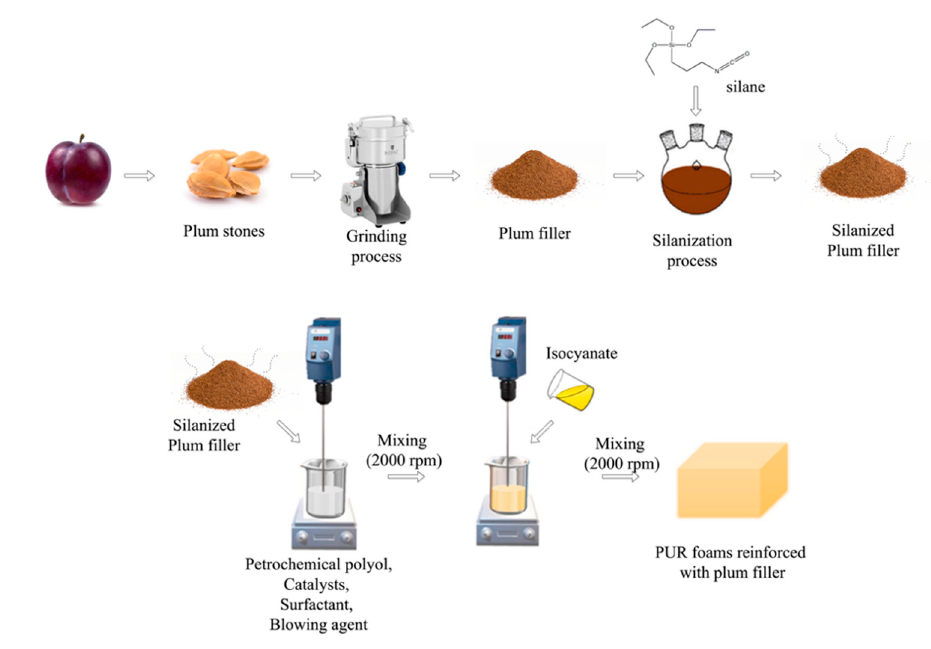
Figure 13. Schematic procedure of the synthesis of polyurethane foams reinforced with unmodified and silanized plum filler.